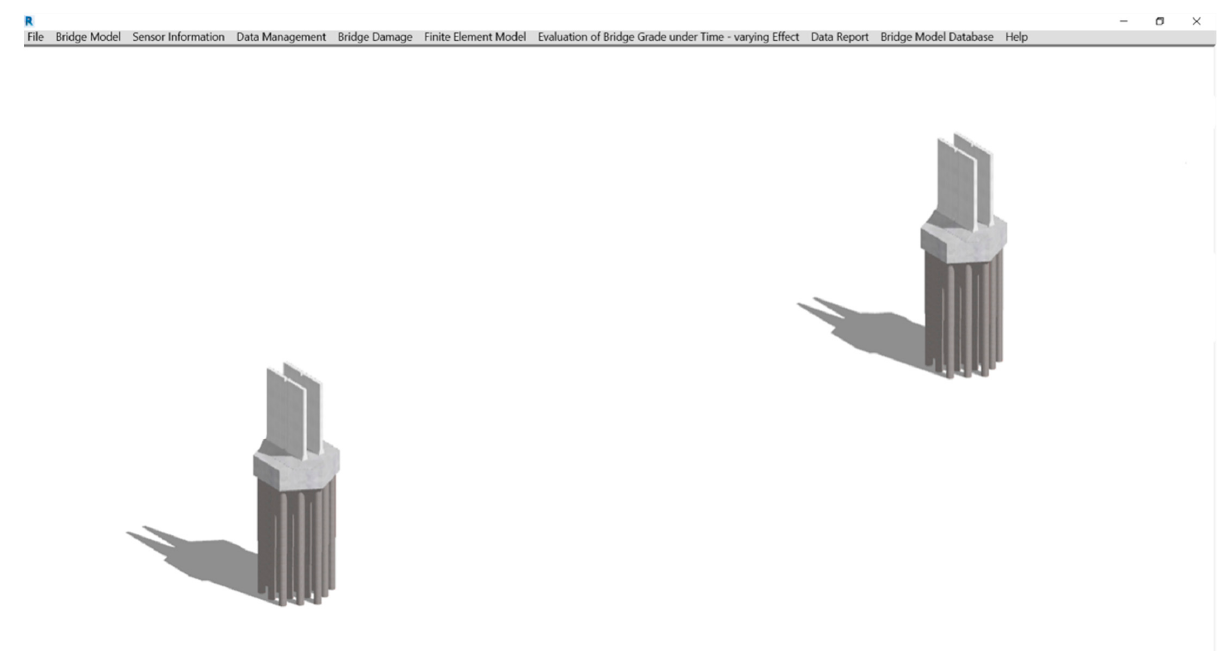
Figure 14. Bridge Foundation Detection Model Database Establishment.